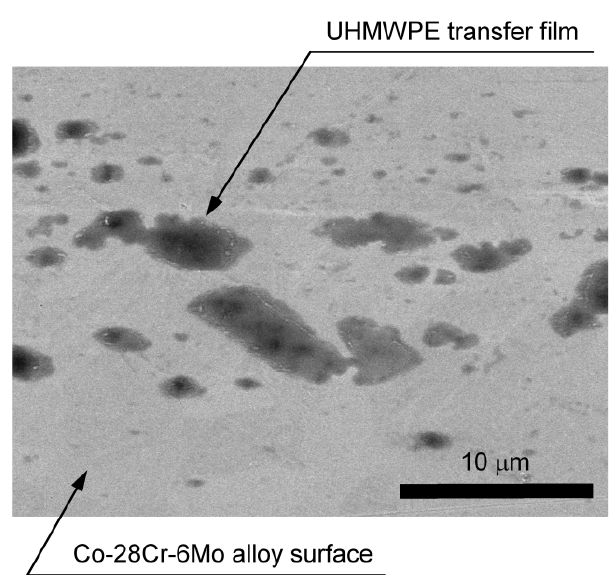
Fig. 2 Scanning electron micrograph of the Co-28Cr-6Mo alloy surface after the transfer